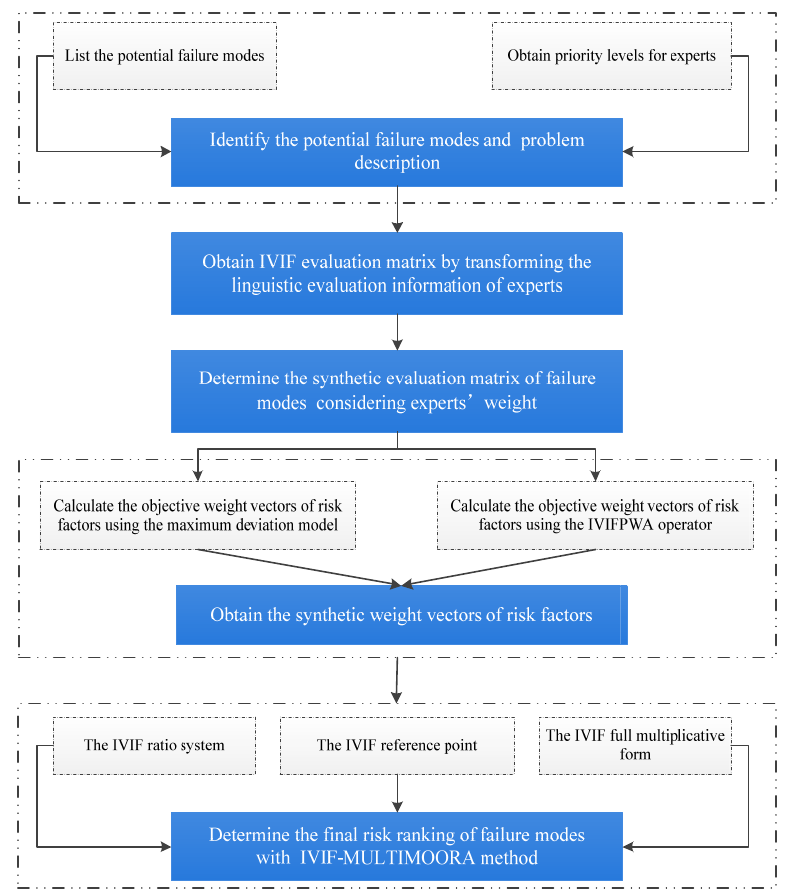
Figure 1. Risk evaluation in Failure Mode and Effect Analysis (FMEA) with interval-valued intuitionistic fuzzy (IVIF)-MULTIMOORA method flow chart.